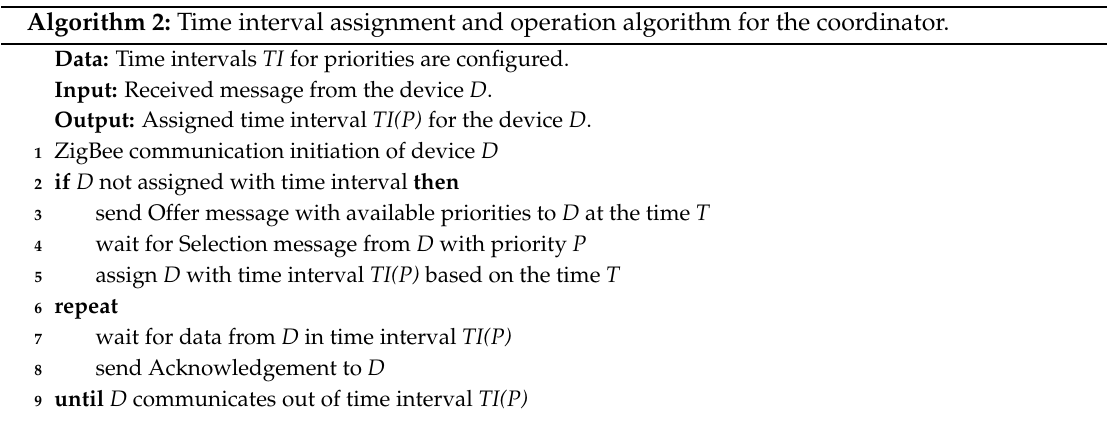
Algorithm 2: Time interval assignment and operation algorithm for the